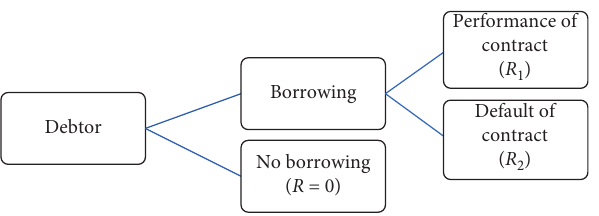
Figure 1: Decision tree of rural household credit Table 1: Game strategy and benefits of participants.